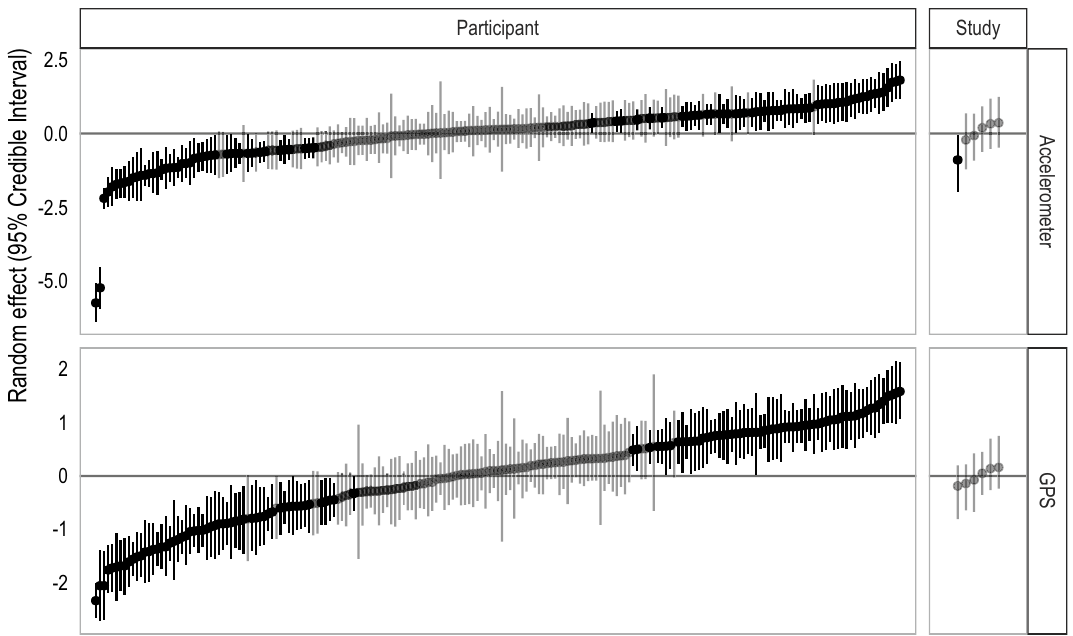
Figure 4. Participant-level (left) and study-level (right) random effect estimates for accelerometer (top) and GPS (bottom). The dots are the mean random effect estimates and the bars are the 95% credible intervals for each participant or study. Credible intervals that include 0 are shaded in grey while those that exclude 0 are shaded in black. The values on the y-axis represent the deviation from the overall average rate of sensor non- collection. There is substantial participant-level variation in missingness, and fairly low study-level variation relative to the participant-level variation. In all panels, estimates have been ordered from lowest (i.e., least sensor non-collection) to highest (most sensor non-collection) median value. Note that the y-axes differ across the